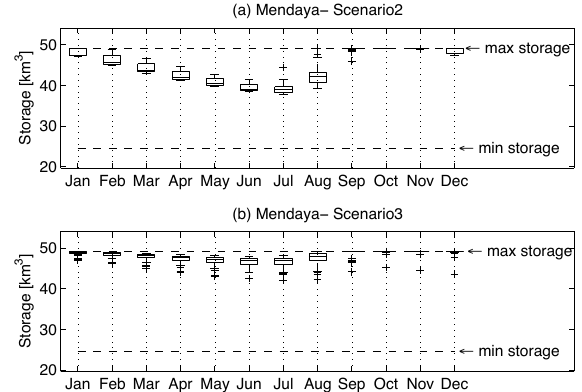
Fig. 4. Boxplots of the drawdown-refill cycles of the Mandaya reservoir in Ethiopia (Blue Nile) – S2 versus S3.